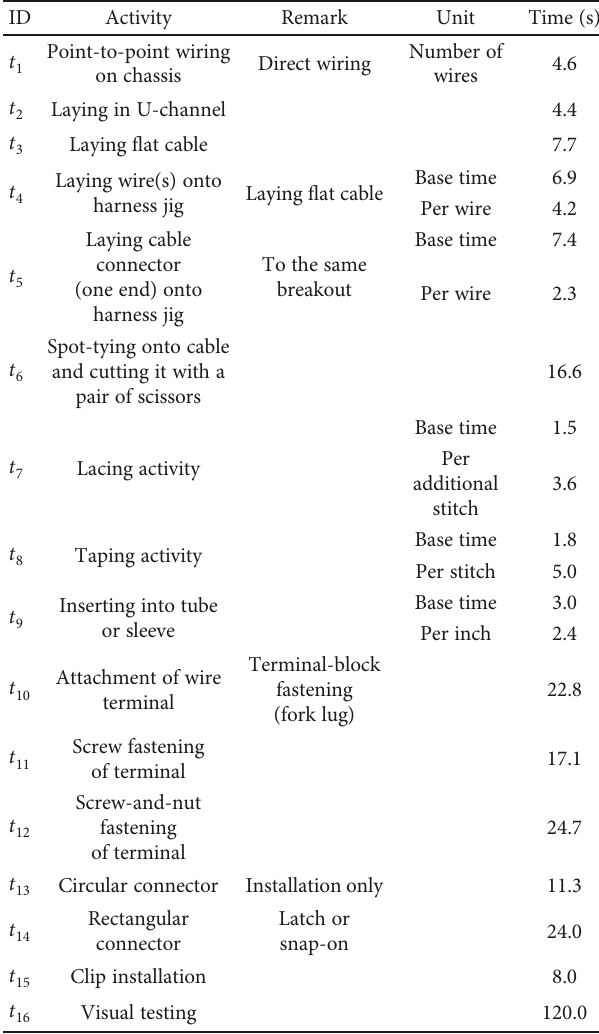
Figure 13: The wire-harness assembly pace conveyor [62]. The conveyor (often referred to as rotary) contains assembly tables consisting of connector and clip fi xtures. Table 7: Types of activities and the related activity times [61]. The activity times are calculated based on fi xed and proportional values, for example, when an operator is laying four wires over one foot, according to the t model, the activity time will be 1 × 6 9s + 4 × 4 4 2 = 23 7 s